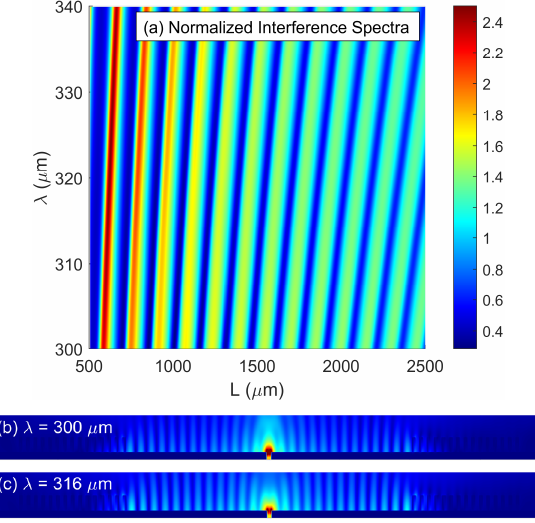
Figure 4. ( a ) Contour plot of normalized transmitted intensity as functions of both separation length L and wavelength λ for proposed SPPs interferometers. Calculated electric field distributions at ( b ) constructive wavelength of 300 μm and ( c ) destructive wavelengths of 316 μm.